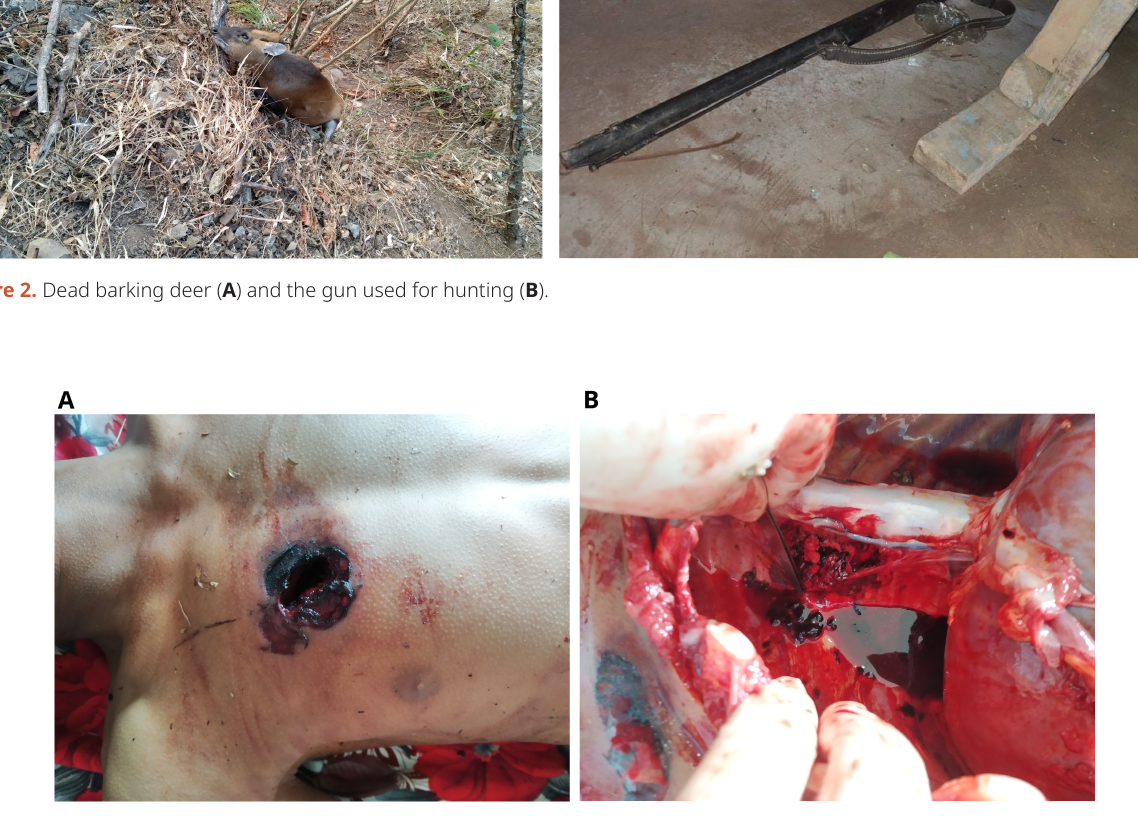
Figure 3. Entry wound in the front of the chest ( A ). The location of the shot in the thoracic spine ( B